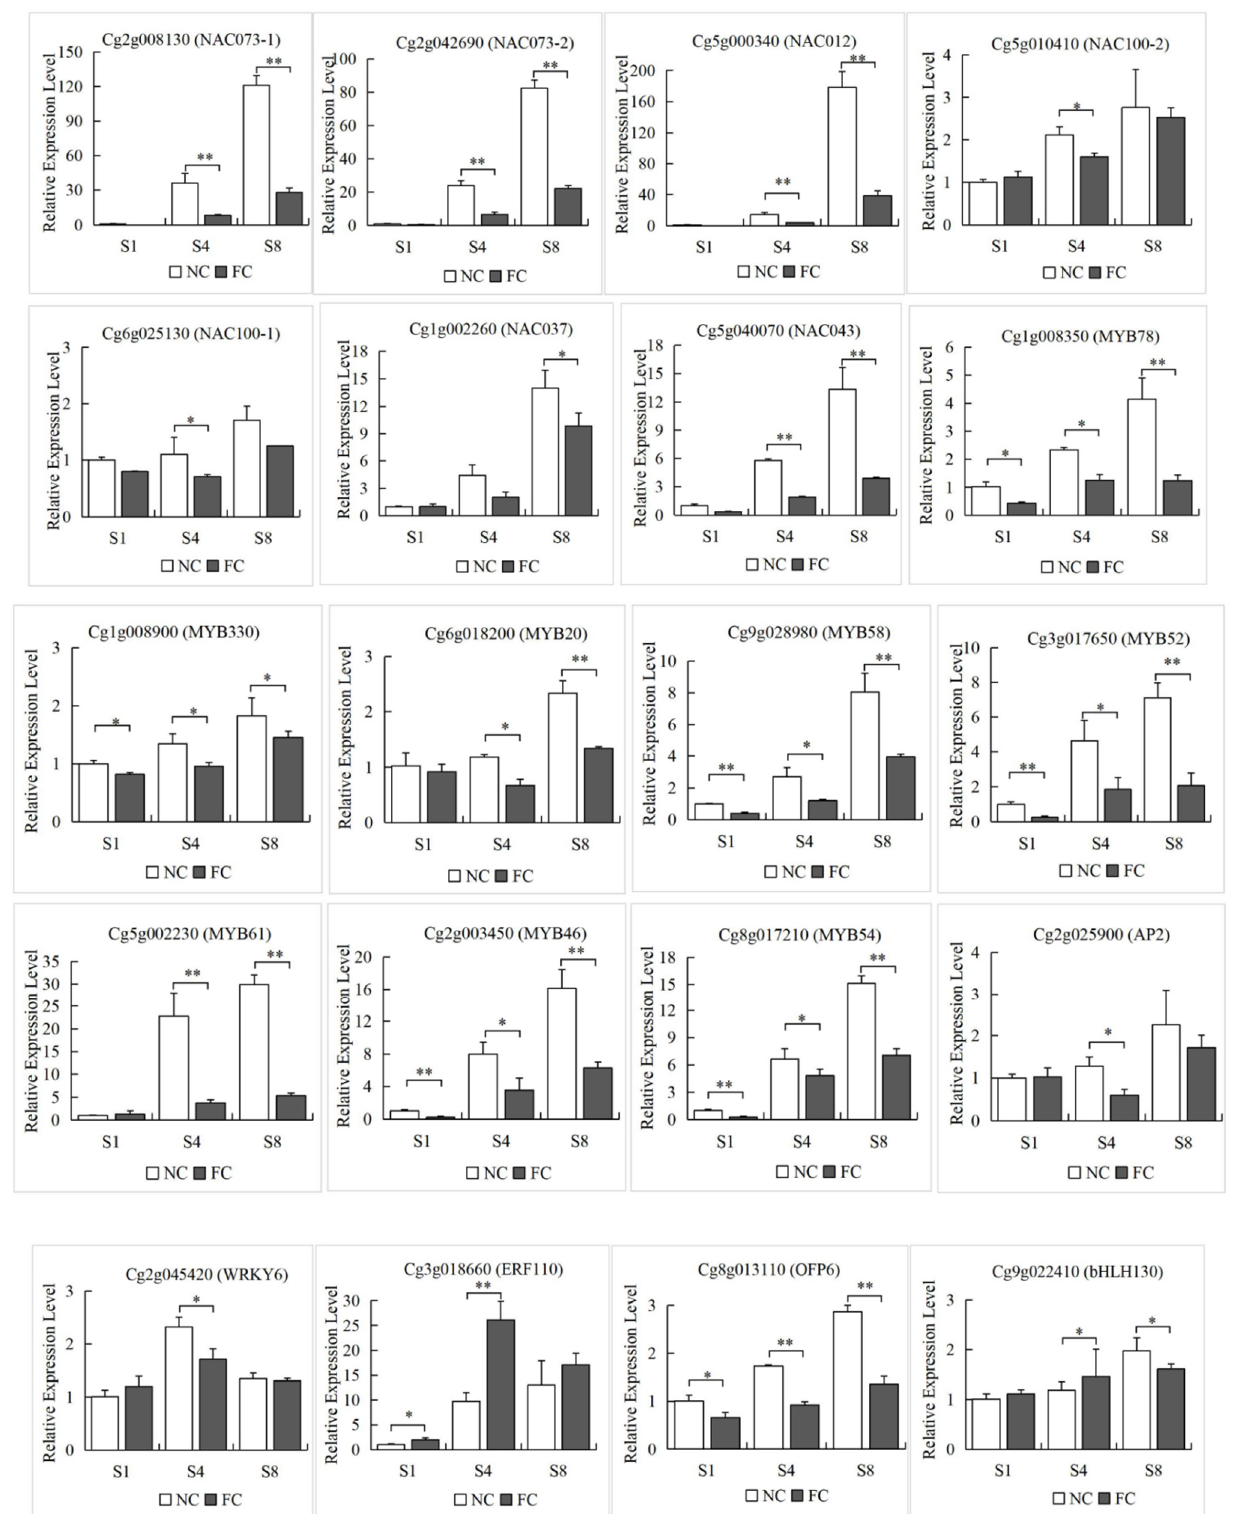
Figure 7. Validation of expression patterns by qRT-PCR of selected DEGs identified in the RNA-seq analysis. The Y-axis represents the relative expression levels. The corresponding bar plot shows the standard deviations (denoted as error bars). The significance of differences compared with FC juice sacs is indicated. Student’s t -test: *: 0.01 < p < 0.05; **: 0.001 < p < 0.01.